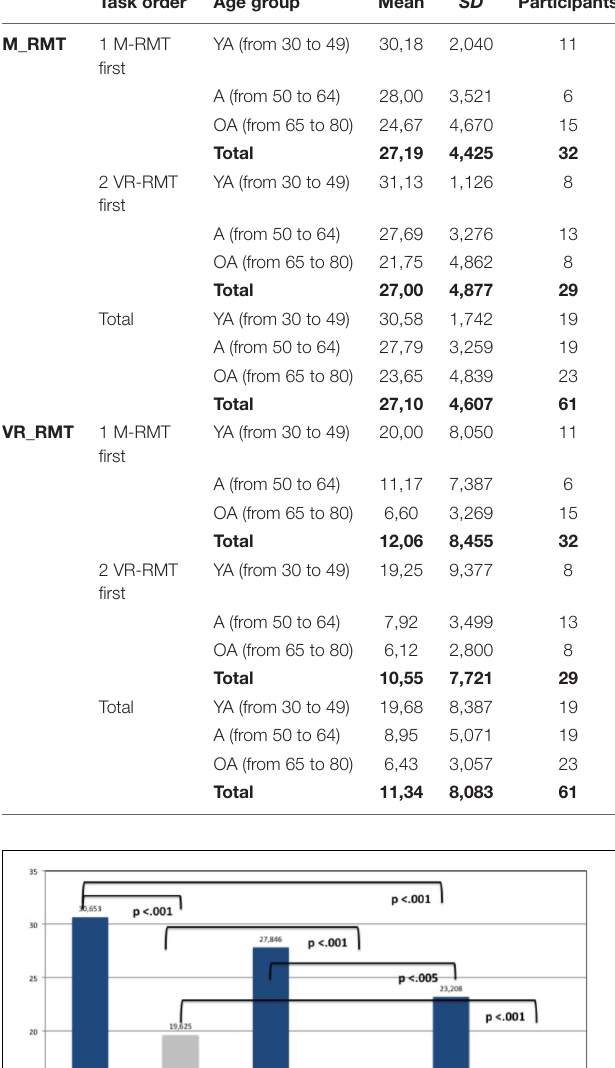
TABLE 1 | Participant’s performances at the M-RMT and VR-RMT according to presentation order and age groups. Task order